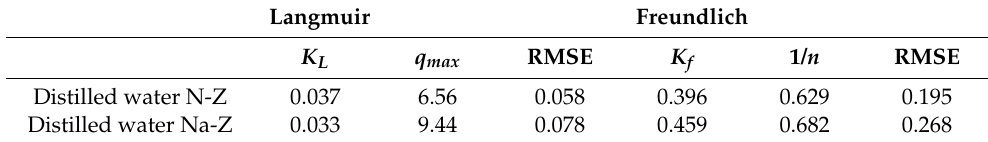
Table 4. Analysis of the adjustment parameters for the isotherm models for the N-Z and Na-Z. Langmuir